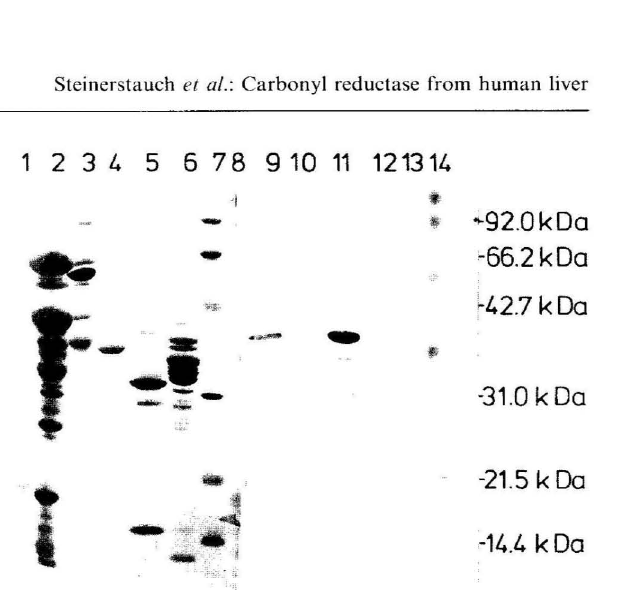
Figure 8. Antibody probing of the polyclonal antiserum pro duced to purified PPH. reductase. Various enzyme preparations were separated on a 12.5% polyacrylamide gel, transferred to nitrocellulose and probed immunologically with diluted anti serum (1 : 2'000) as described in the text (right hand side of the blot, lane 9 to 14); left hand side: amido black stain of the transferred proteins (lane 1 to 7). From outside to the center: mixture of prestained standard proteins: lysozyme (17 kDa), soybean trypsin inhibitor (27 kDa), carbonic anhydrase (39 kDa), ovalbumin (50 kDa), bovine serum albumin (75 kDa), phosphorylase b (130 kDa) (lanes 1,8 + 14); human liver se piapterin reductase from early purification steps (lanes 2, 3, 12, 13); PPH 4 reductase after chromatography on Mono Q FPLC (lanes 4 + 11); partially purified prostaglandine-9-keto reduc tase from pig kidney (lanes 5 + 10); PPH. reductase after chro matography on Butyl Fractogel (lanes 6 + 9); mixture of stand ard proteins containing: lysozyme (14.4 kDa), soybean trypsin inhibitor (21 .5 kDa), carbonic anhydrase (31 kDa), ovalbumin (42.7 kDa), bovine serum albumin (66.2 kDa), phosphorylase b (92 kDa) (lane